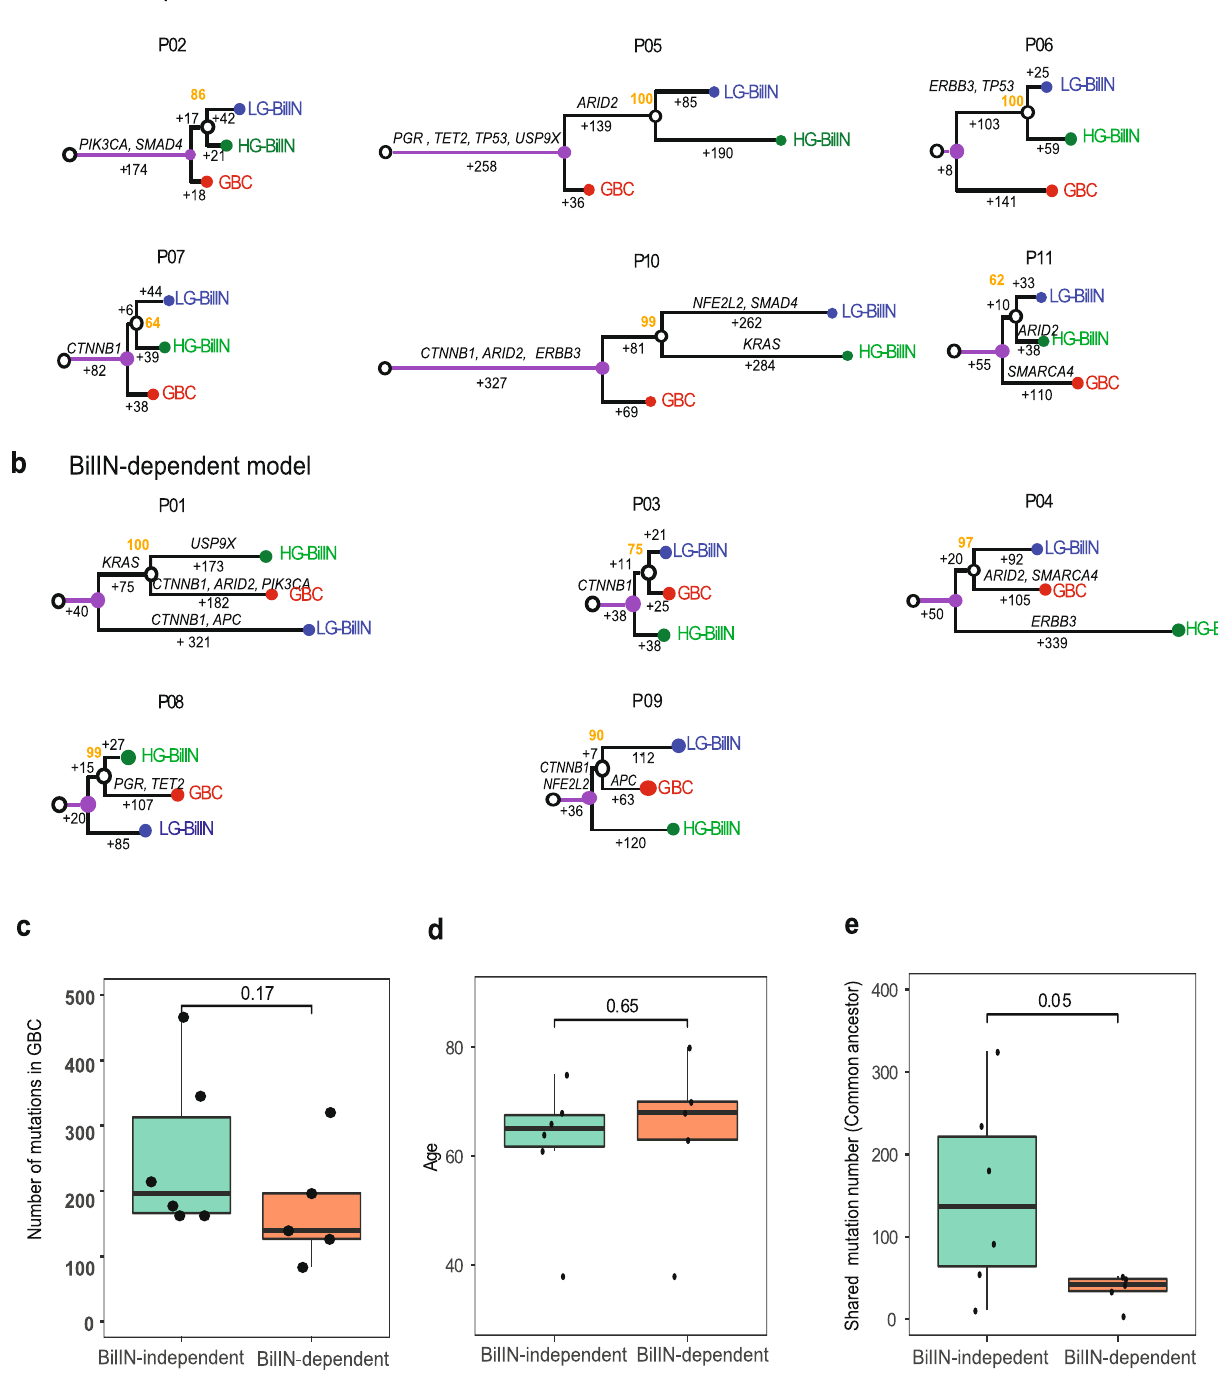
Fig. 3 Phylogenetic trees of gallbladder tumors. a BilIN-independent group ( n = 6), and b BilIN-dependent group ( n = 5). The branch lengths are proportional to the number of supporting mutations, which were labeled. Potential driver mutations are annotated along the branches. Bootstrap values are shown in orange. c The number of mutations in GBC samples (BilIN-independent: n = 6; BilIN-dependent: n = 5), d age at diagnosis (BilIN-independent: n = 6; BilIN-dependent: n = 5), and e the mutations accumulated in the common ancestor state of LG-BilIN/HG-BilIN/GBC, in the BilIN-independent and BilIN-dependent groups (BilIN-independent: n = 6; BilIN-dependent: n = 5). The middle line in the box is the median, the bottom, and top of the box are the fi rst and third quartiles, and the whiskers extend to 1.5× interquartile range of the lower and the upper quartiles, respectively. Raw p -values based on the two-tailed Wilcoxon rank-sum test are